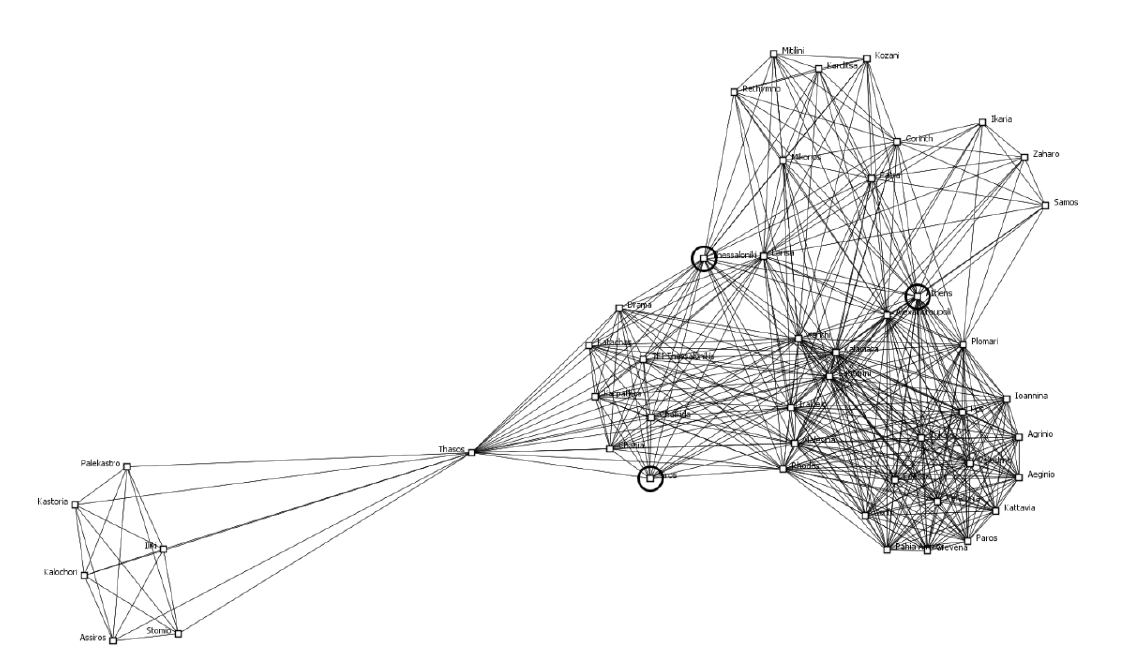
Figure 4. Folded |A | x |A| social network